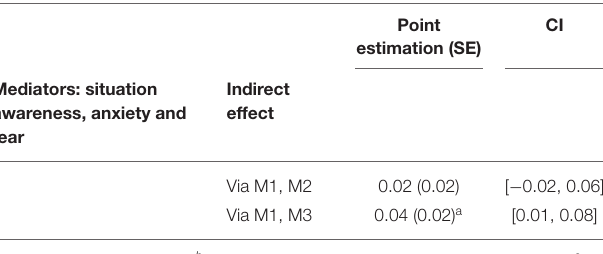
TABLE 2 | Results of serial mediation